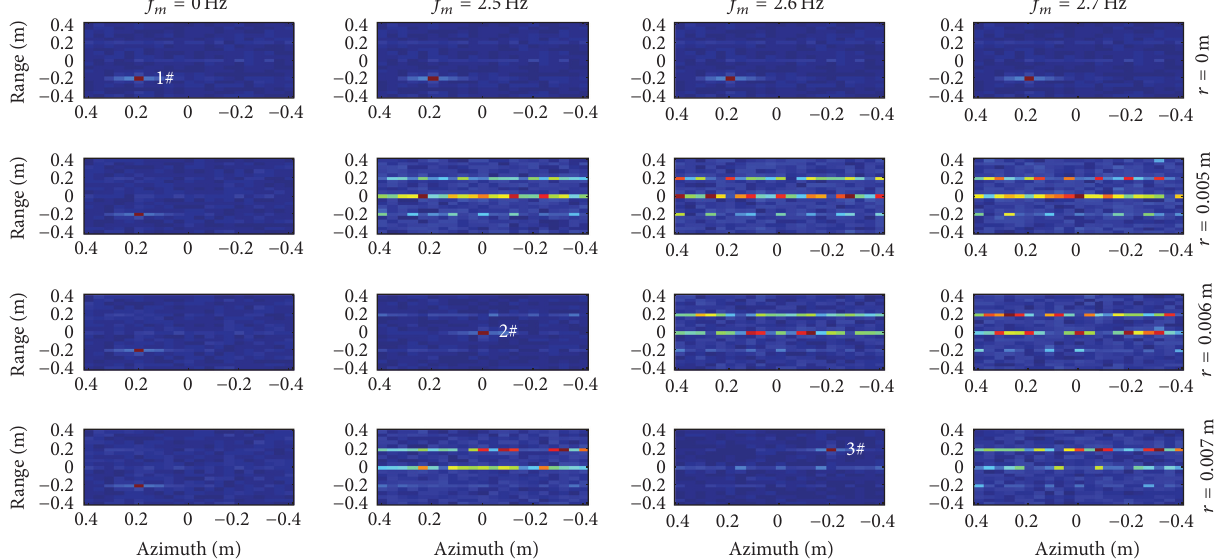
Figure 6: THz-SAR image of point targets in Table 2 under − 10dB SNR, refocused via correlation imaging.